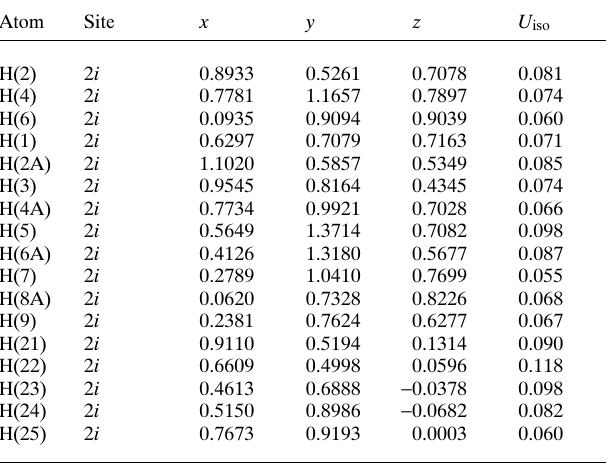
Table 2. Atomic coordinates and displacement parameters (in Å 2 ) .